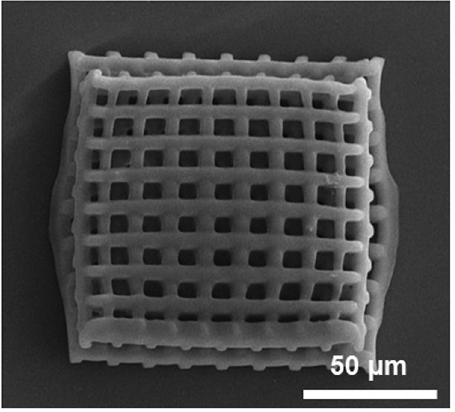
Figure 4: SEM image of the LCE - based woodpile